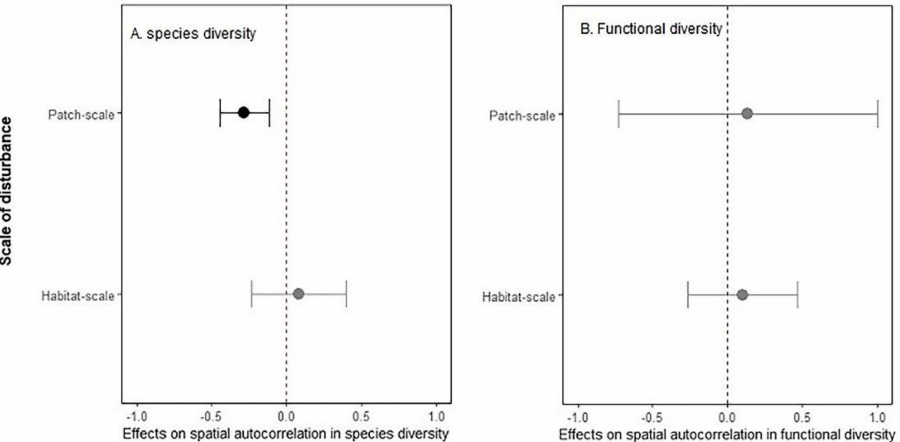
Figure 3. Disturbance effects on spatial autocorrelation in species ( A ) and functional diversity ( B ) for patch-scale and habitat-scale disturbances. Shown in the figure is mean (solid point) and 95% confidence intervals (solid line). Statistically significant effects are shown in dark colour, and non-significant effects are shown in grey.